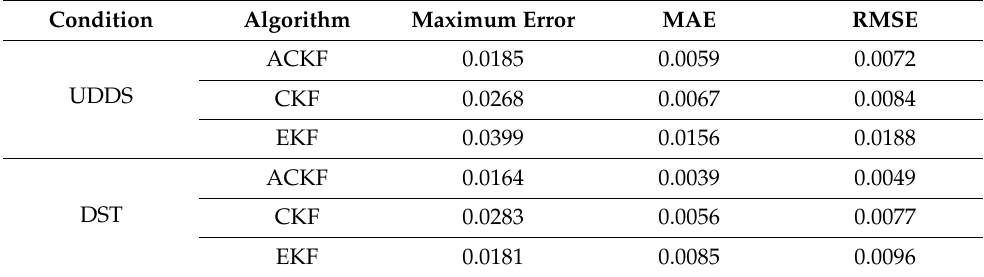
Table 5. Errors of SOC estimation with different algorithms.